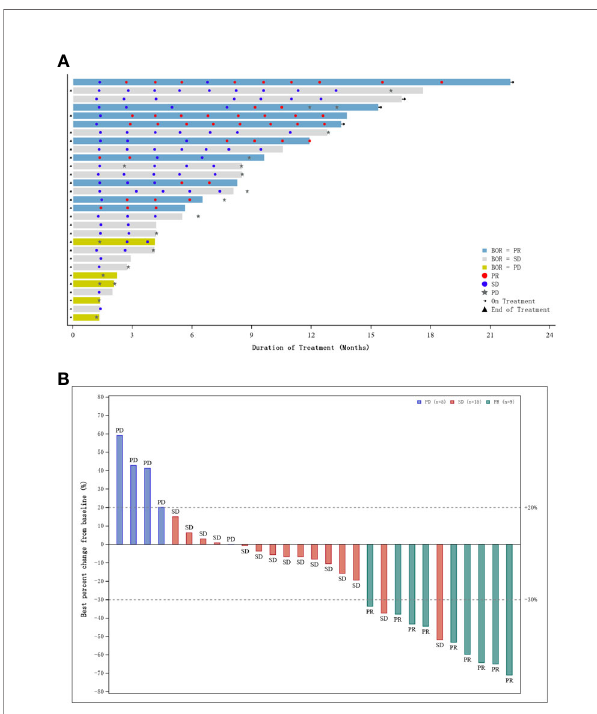
FIGURE 2 | (A) Swimmer plot of patients who underwent at least two post- baseline tumor assessments; (B) Waterfall plot of best percentage change from baseline in sum of diameters with best overall response.